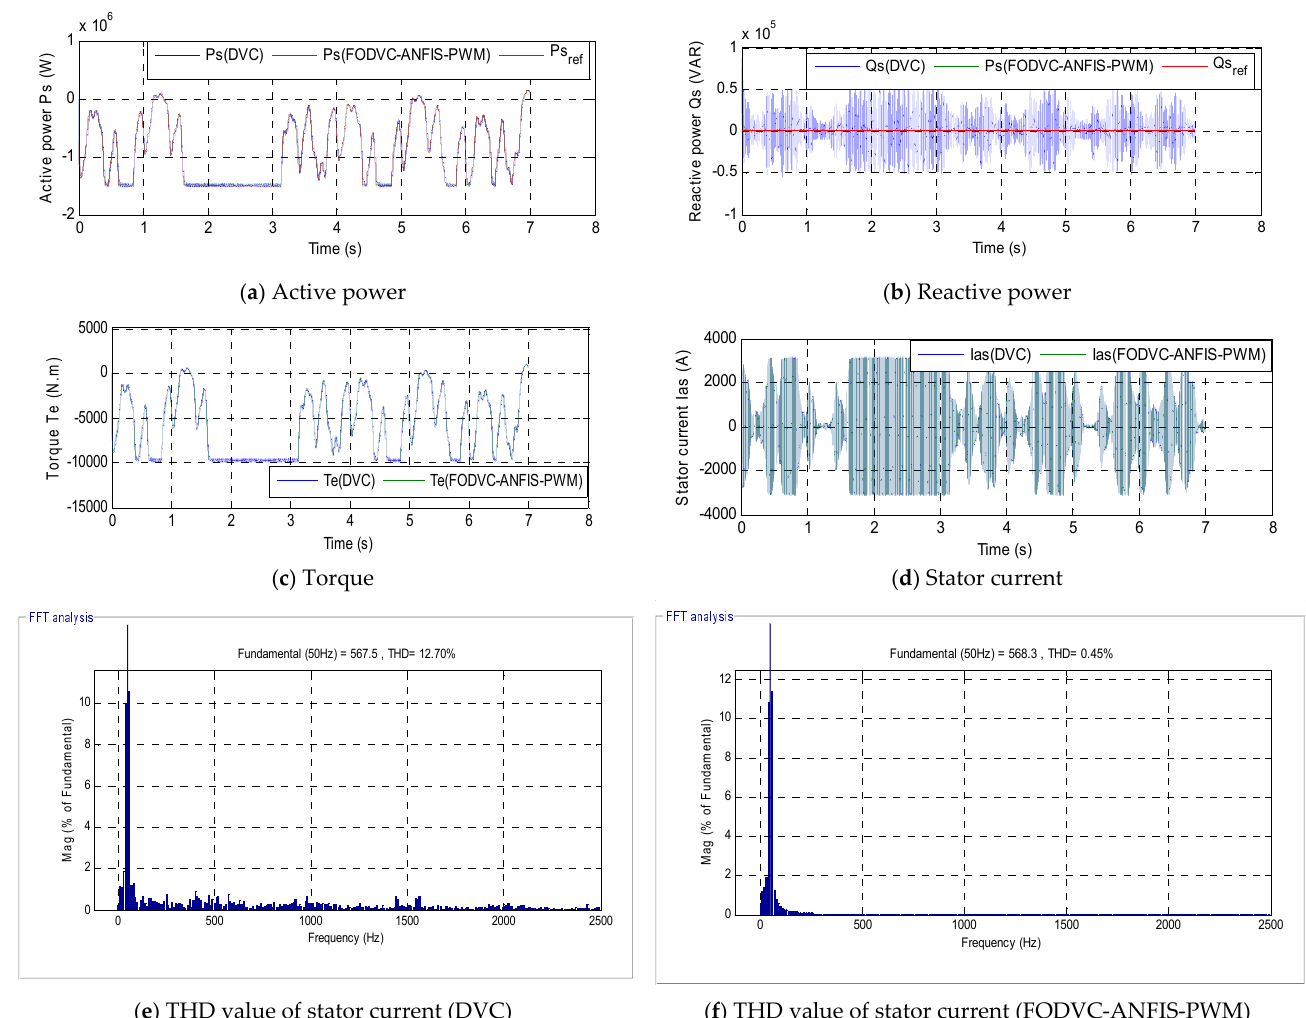
Figure 17. Simulated results from the second test.